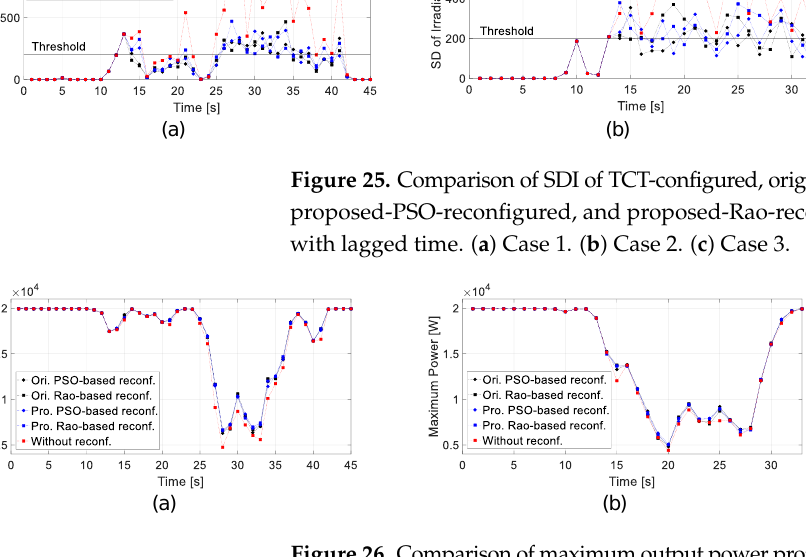
Figure 26. Comparison of maximum output power profiles of TCT-configured, original-PSO-reconfigured, original-Rao-reconfigured, proposed-PSO-reconfigured, and proposed-Rao-reconfigured PV arrays under three shading cases with lagged time. ( a ) Case 1. ( b ) Case 2. ( c ) Case 3. Table 5. Summary performance metrics of PV array under PSC with time lagging.